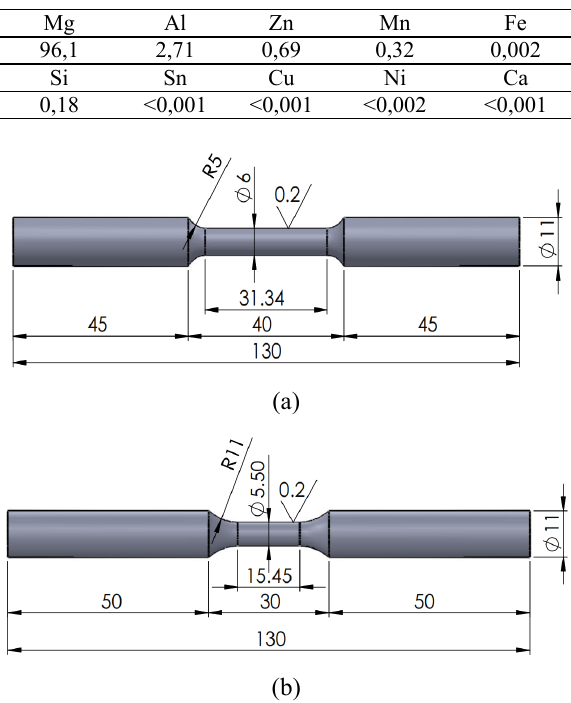
Figure 1. Specimen shape and size for (a) tensile test and (b) low cycle fatigue test (unit in mm)